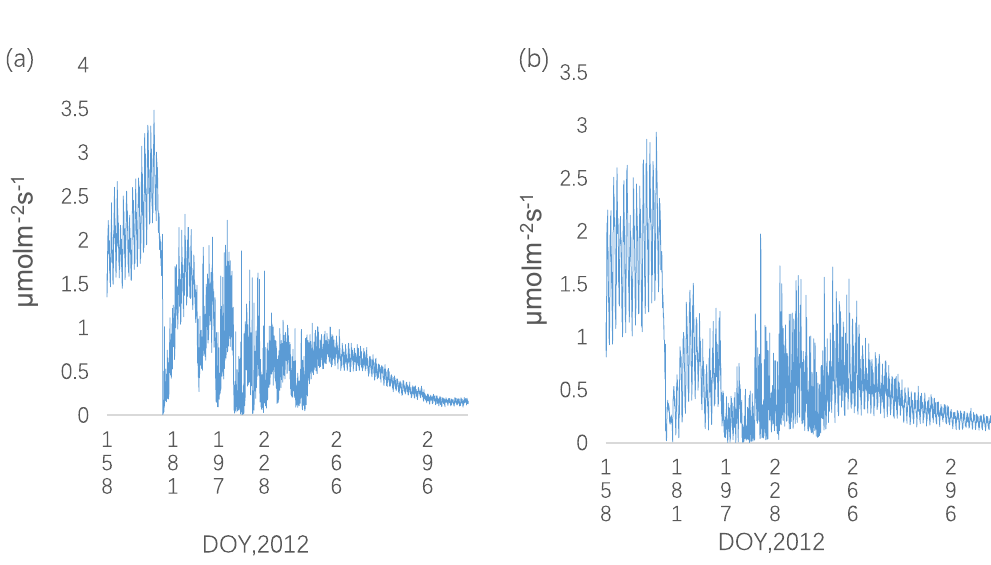
Figure 3. Seasonal variation of soil surface CO2 efflux (a) in the TC treatment (b) in the MC